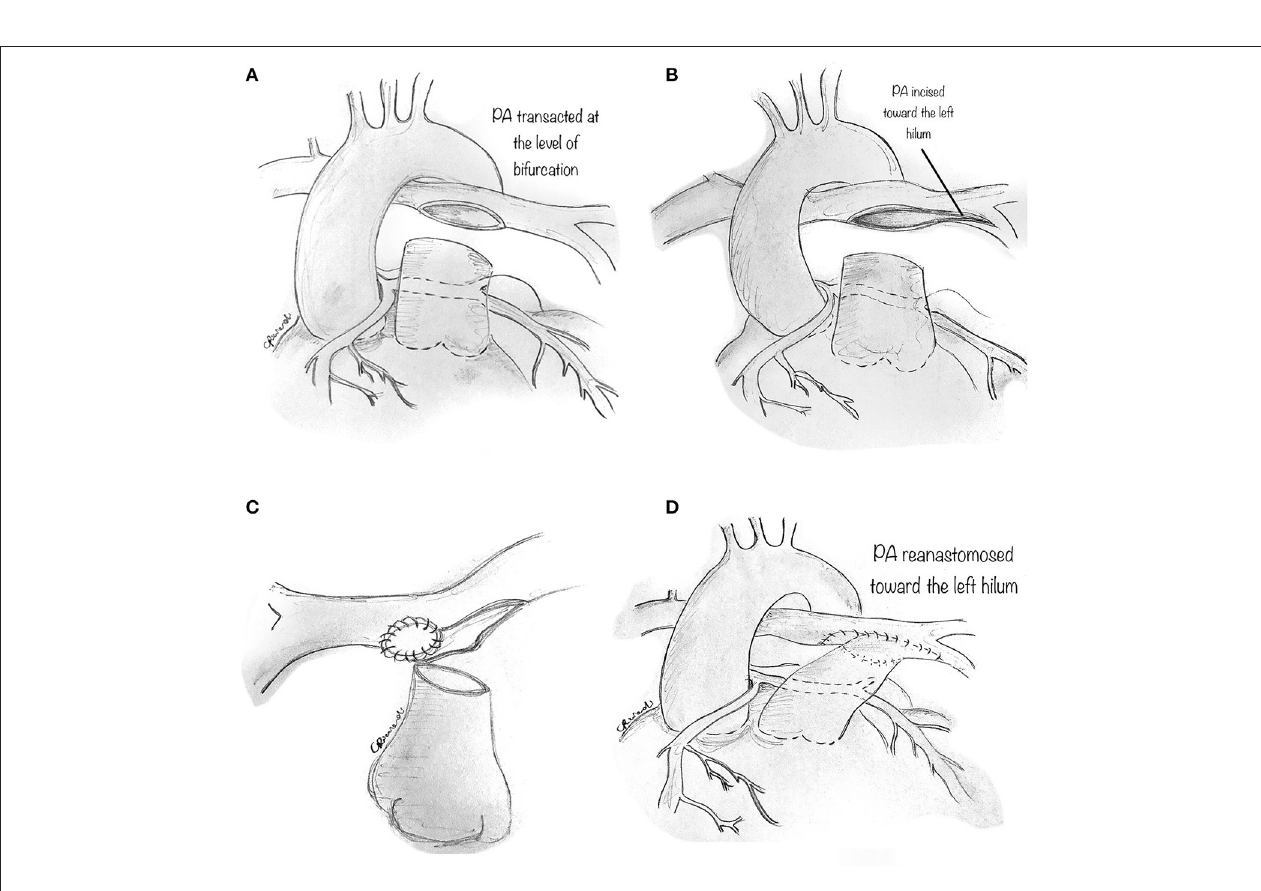
Frontiers in Cardiovascular Medicine |